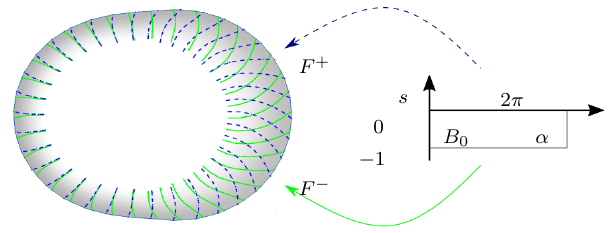
Fig. 1. Graphical representation of the F ± : B 0 → R 2 mappings that define the lamellipodium. The s = 0 boundary of B 0 is mapped to the membrane of the cell and the s = − 1 to the minus-ends of the filaments inside the cell. The filaments and the rest of the functions of α are periodic with respect to α . The “filaments” plotted in the lamellipodium correspond to the discretization interfaces of B 0 along the α direction. The grey colour represents the density of F-actin inside the